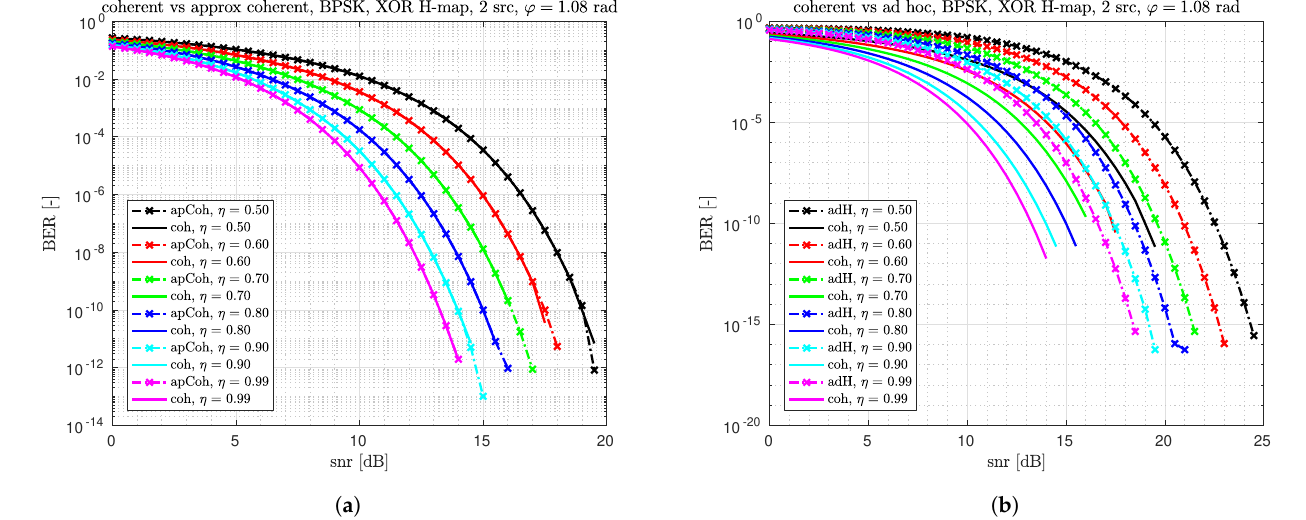
Figure 6. H-BER of the coherent (coh) vs. the approximate coherent (apCoh) detector ( a ) and the coherent vs. ad hoc (adH) detector ( b ). ( a ) H-BER of coherent vs. the approximate coherent detector. ( b ) H-BER of coherent vs. ad hoc differential detector.